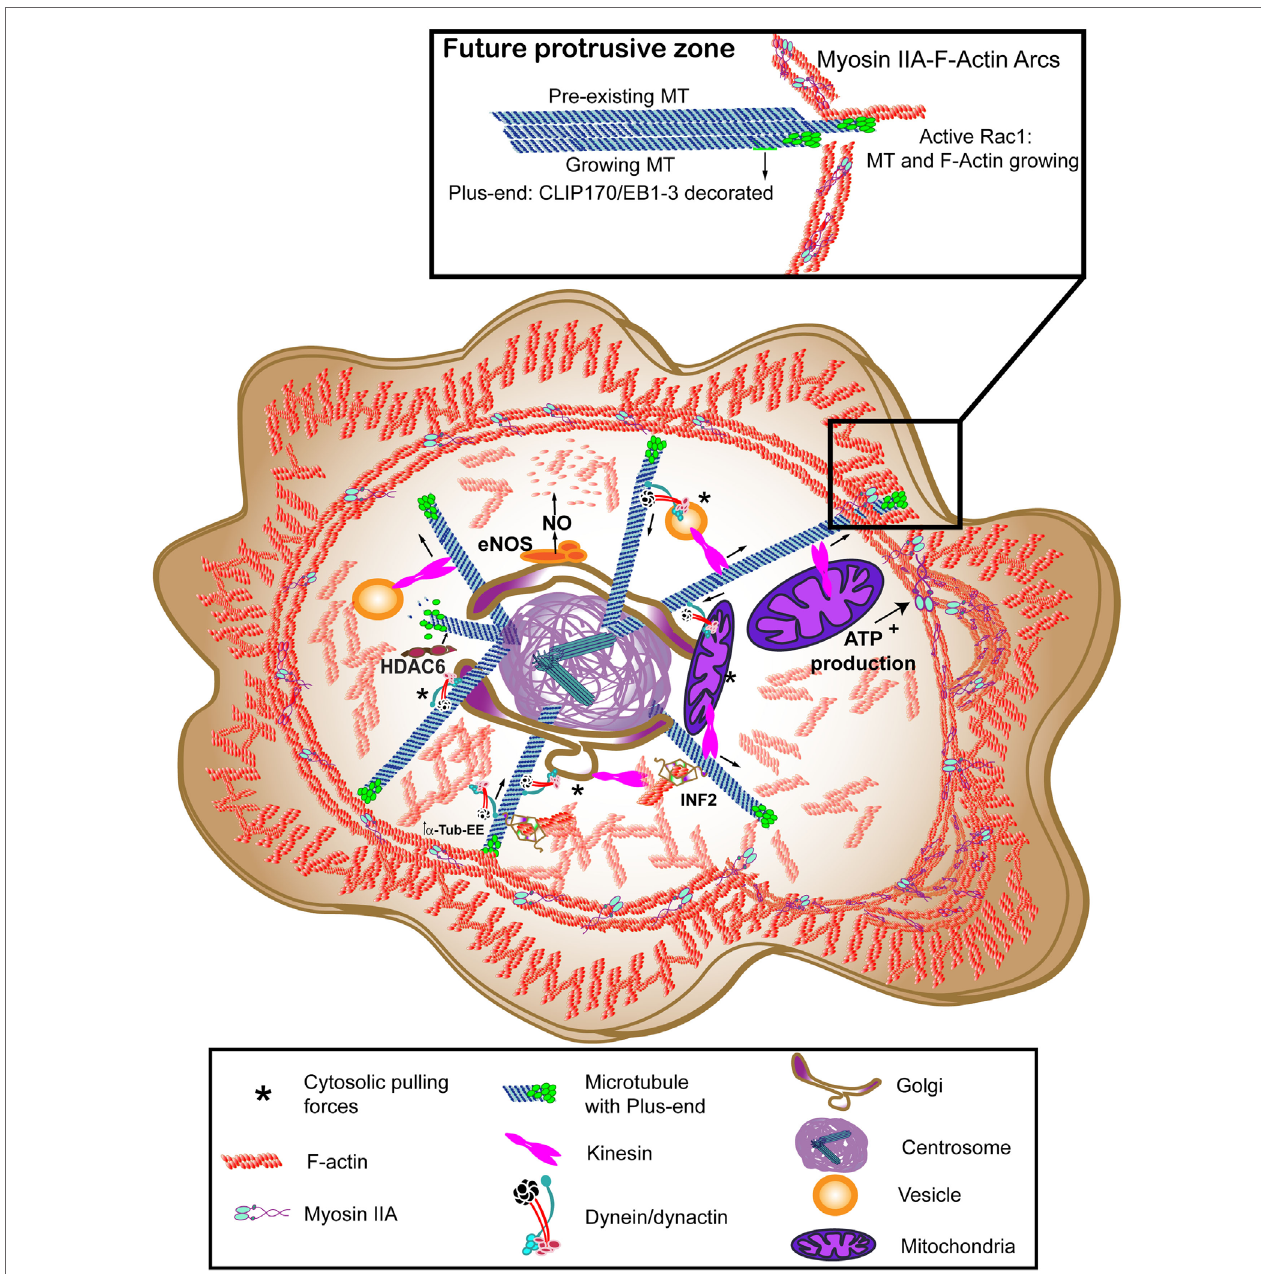
FigURe 2 | Molecular motors at motion to rearrange the cytoskeleton at the immune synapse (IS). Myosin IIA provides the lymphoctye function-associated antigen-1 (LFA-1)-dependent actin ring with contractile activity, thereby helping the centripetal movement of surface proteins. Dynein/dynactin may interact directly with receptors or move vesicles to allow recycling, walking toward the minus-end of microtubules (MTs) (centrosome). Kinesin-1 helps the traffic from the centrosome to the periphery. Vesicular traffic allows secretion and mitochondria can provide the adenosine tri-phosphate (ATP) needed for Myosin IIA activation. The forces exerted by these motors between the organelles and the cytoskeleton constitute the cytosolic pulling forces, that may provide a docking mechanism for the centrosome. The translocated centrosome provides the IS with multiple signaling, scaffold and modifying proteins that can regulate relevant post-translational modifications (PTMs) for actin or tubulin cytoskeletons, such as endothelial nitric oxide synthase (eNOS) for β -actin nitrosylation, histone deacetylase 6 (HDAC6) for deacetylation, or inverted formin-2 (INF2) to allow detyrosination of MTs. The images in the figure are not